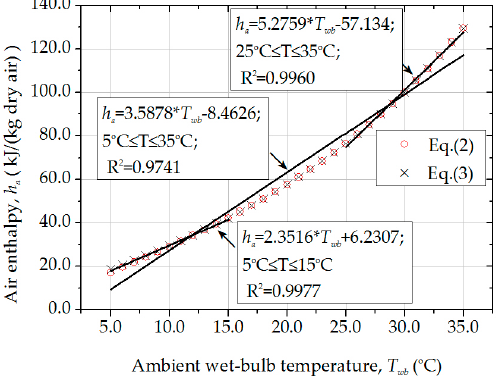
Figure 2. Air enthalpy vs. wet-bulb temperature.